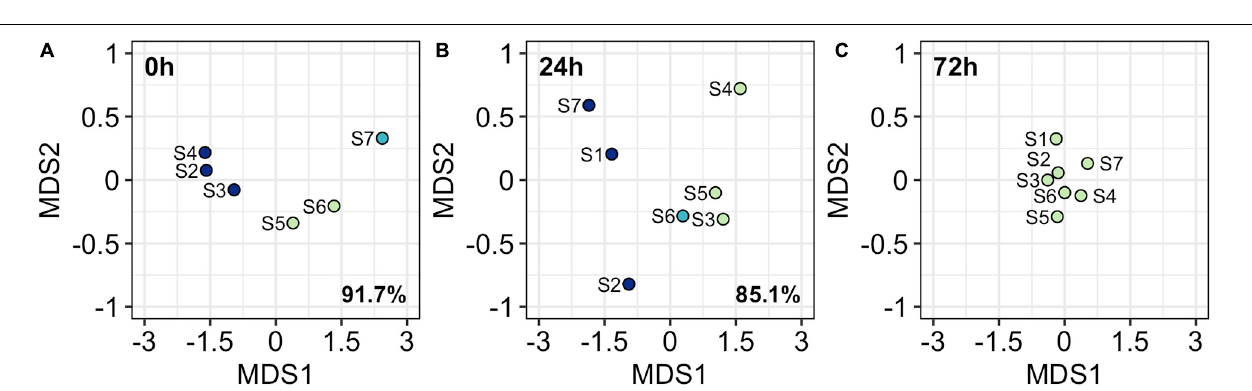
FIGURE 6 | Bar plots of contribution (%) of Eukaryotes (Euk), Prochlorococcus sp. (Pro) and Synechococcus sp . (Syn) to total integrated biomass at 0 h (a) , 24 h (b) , and 72 h (c) for every station.